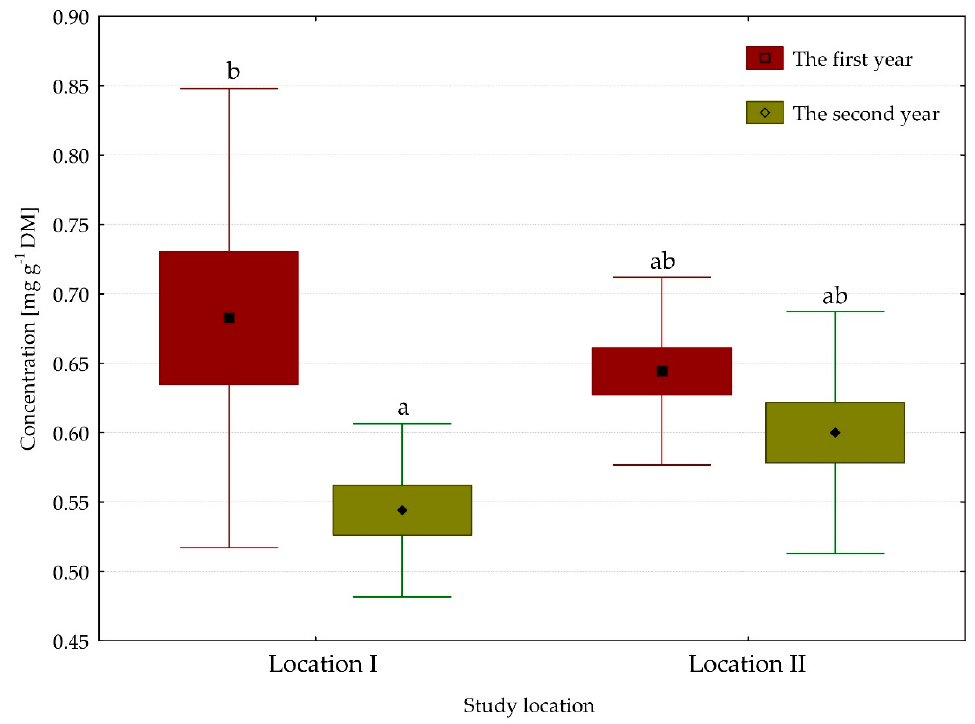
Figure 5. β -carotene content in Melica nutans leaf blades from two natural forest stands.